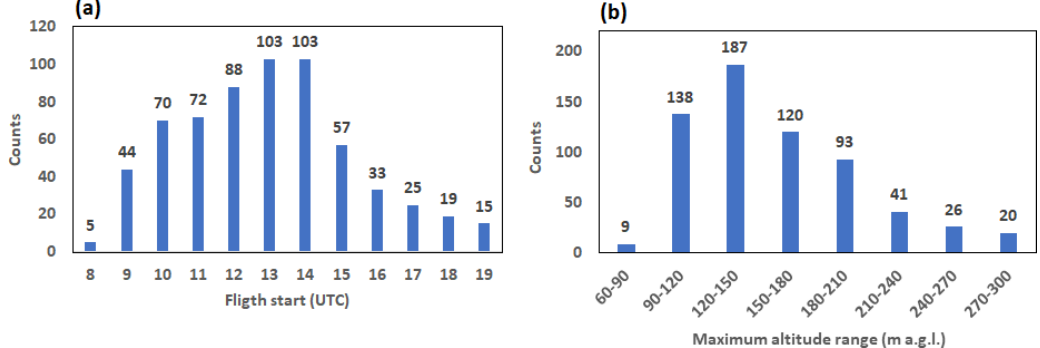
Figure A1. Balloon flight characteristics: (a) flight take-off; (b) maximum flight altitude.